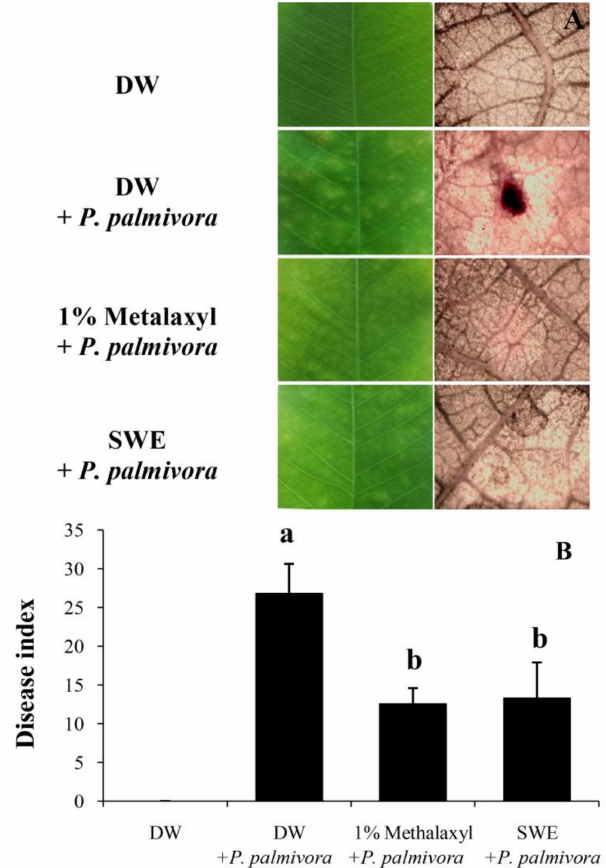
Figure 2. Leaf lesions and phloroglucinol stainings ( A ) and average disease index was calculated based on the percentage of leaf area e ff ected using a 4 (0–3)-point disease rating scale ( B ) in four sets of elicitation bioassay at 5 DAI (n = 5). According to Sche ff e’s Multiple range test, di ff erent letters indicate significant di ff erences among treatments ( p >